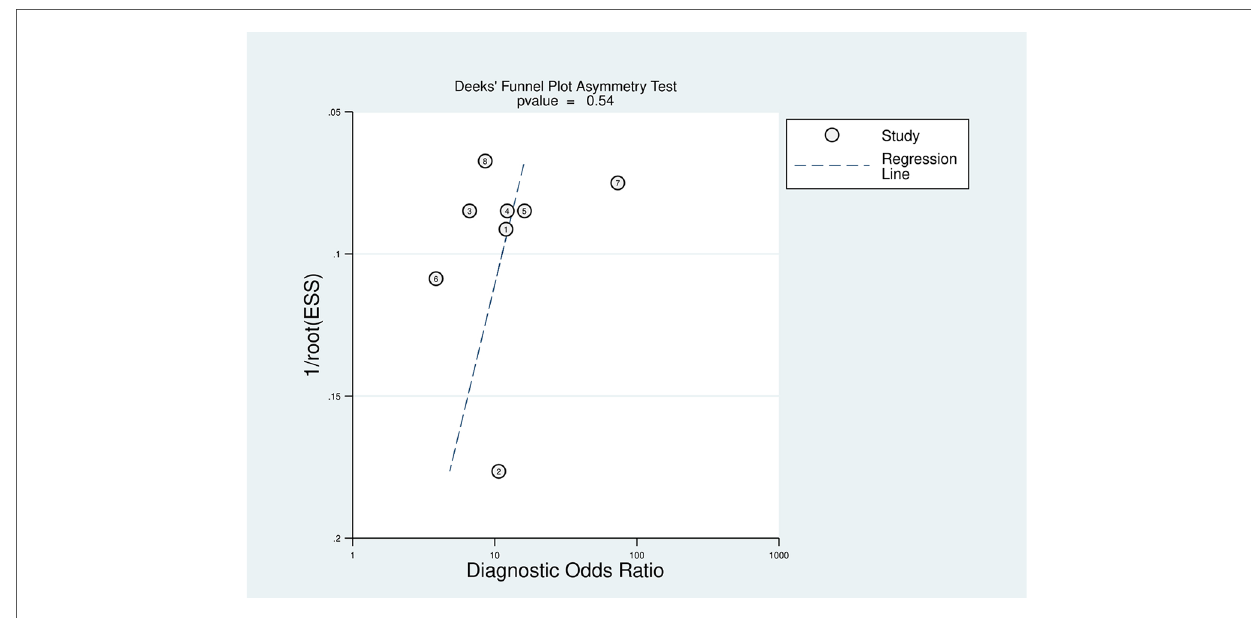
FIGURE 9 Deeks ’ funnel plot asymmetry test was used to assess the publication